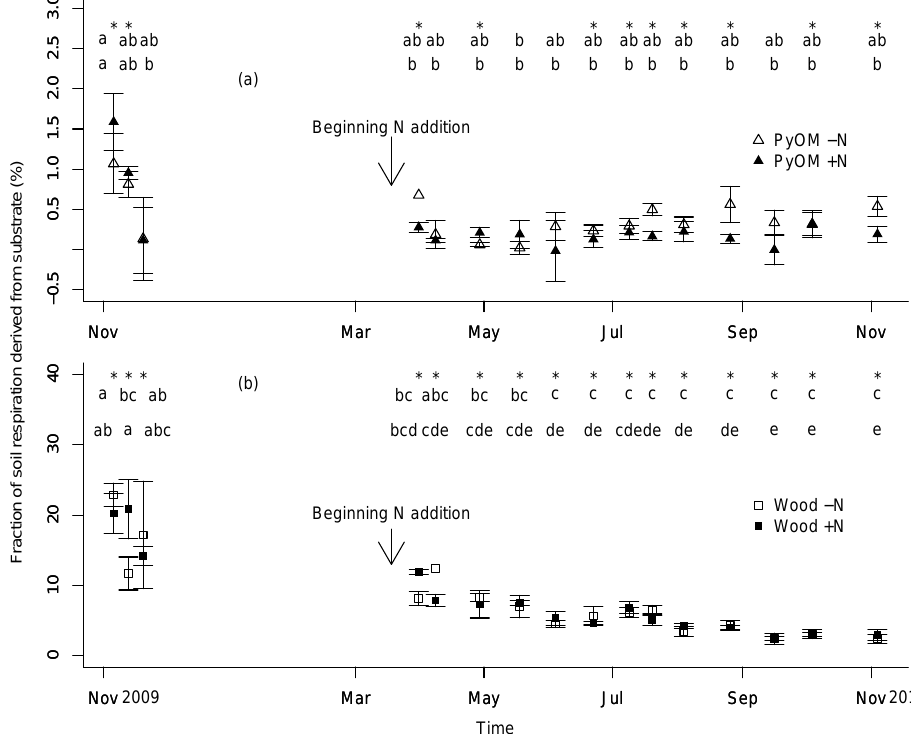
Figure 2. Fraction of soil respiration derived from PyOM (a) and from wood (b) . The sampling dates within the same treatment with different Figure 2 letters (on the top) are significantly different ( p < 0 . 05 TukeyHSD test). The first line of letters refers to the ambient N treatment and the second to the increased N treatment. Error bars represent the standard error of the mean ( n = 3). Asterisks ( ∗ ) indicate when the fraction is significantly different from 0 (ambient and increased N treatment were pooled together, n = 6, P < 0 .